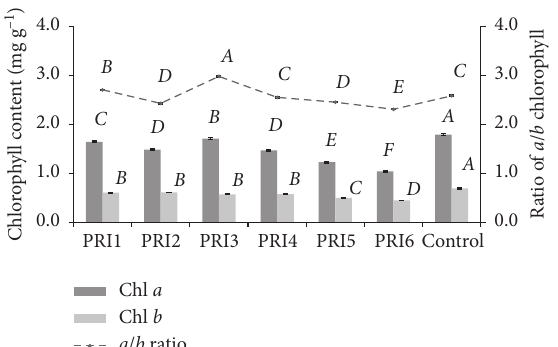
Figure 5: Leaf pigment concentrations of PMK (R) 3 rice by split root experiment. Changes in leaf chlorophyll a, b, and a/b ratio at different irrigation treatments. Error bars indicate one standard error of the mean. Different letters denote significant differences among means derived using an ANOVA and Student’s t